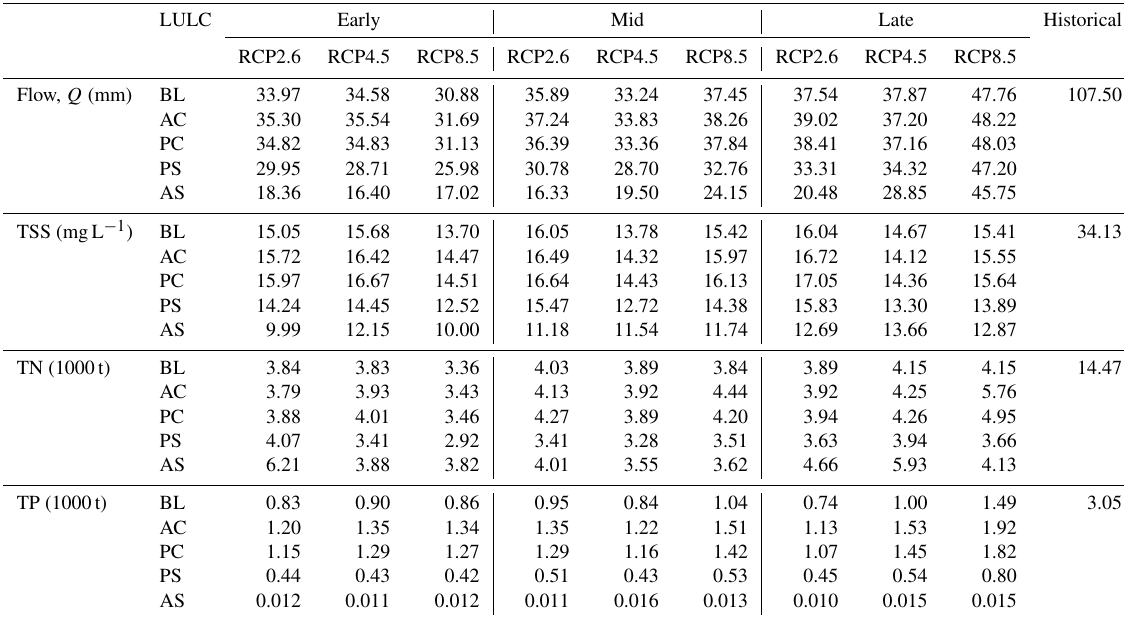
Table A2. Standard deviation of Q , TSS, TN and TP across years (in each 20-year